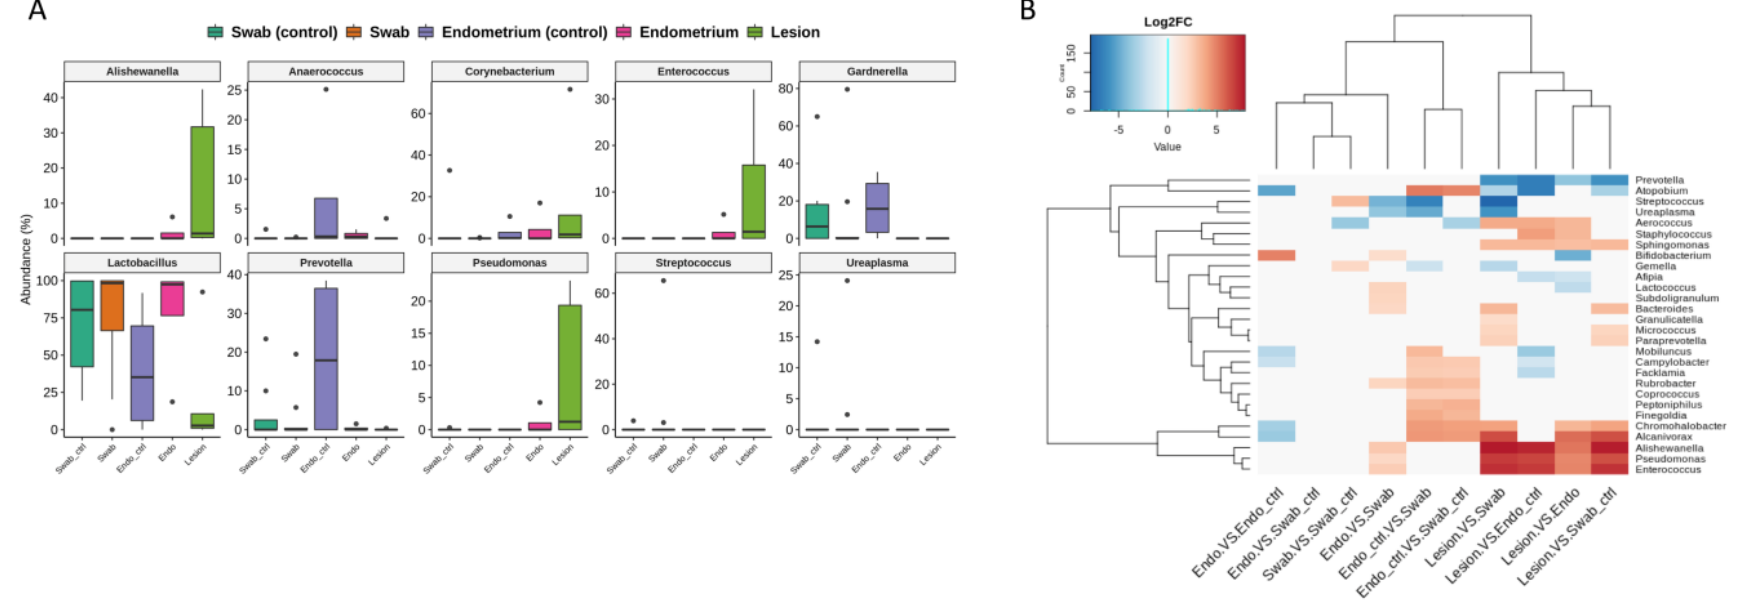
Figure 4. Relative and di ff erential abundances. ( A ) Boxplots represent the most abundant genera detected and their distribution in the samples. Swab_ctrl—control swab from vaginal fluid; Swab—case swab from vaginal fluid; Endo_ctrl—control endometrial tissue; Endo—case endometrial tissue; lesion—samples from endometriosis lesion. Black solid points represent outlier samples for each group. ( B ) Di ff erential abundance heatmap comparing all the collection sites from case and control samples. Results are showed as the log2FC for the di ff erentially detected genera. Most abundant genera are showed as red values considering the first sample category in the bottom legend.